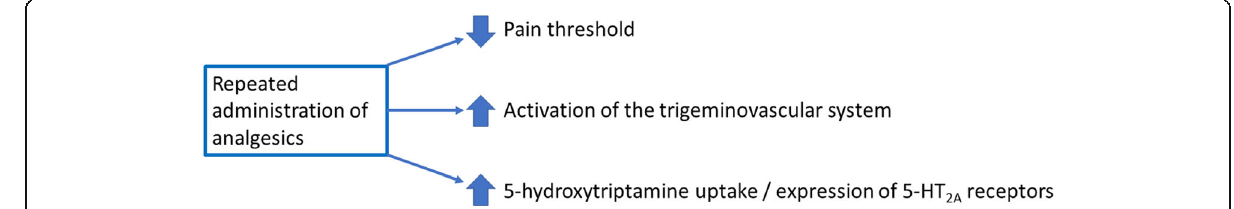
Fig. 2 Simplified summary of changes produced by repeated administration of triptans or